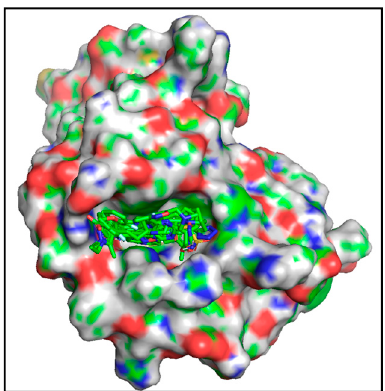
Figure 3. The protein complexes of PB2 CBD with active compounds. The active compounds are represented with colored stick models.